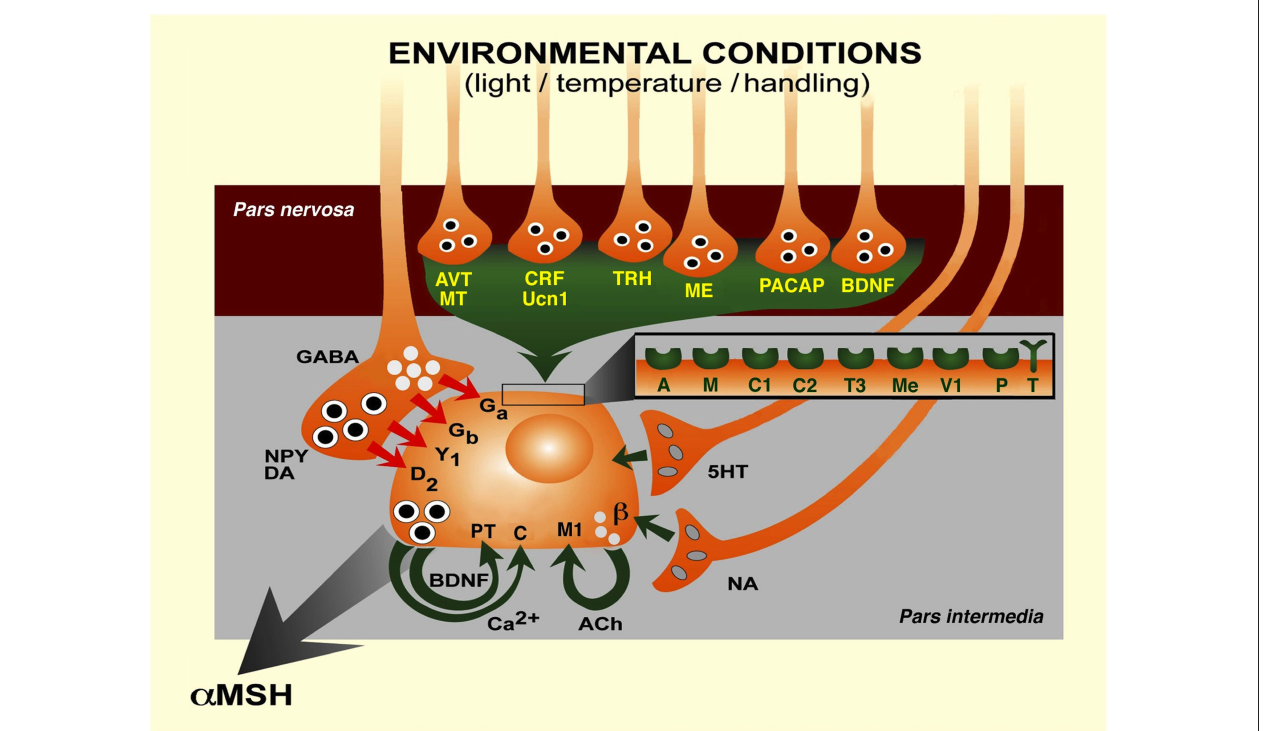
calcium ion; CRF, corticotropin-releasing factor; D , dopamine D receptor; DA, 2 2 dopamine; G , GABA receptor; G , GABA receptor; GABA, γ -aminobutyric acid; a A b B M, mesotocin receptor; M1, muscarinic M1 receptor; ME, metenkephalin; Me, metenkephalin receptor; MT, mesotocin; NA, noradrenalin; NPY, neuropeptide Y; P, P75 NTR receptor; PACAP, pituitary adenylyl cyclase-activating polypeptide; T, TrkB receptor; T3, thyrotropin-releasing hormone receptor 3; TRH, thyrotropin- releasing hormone; Ucn1, urocortin 1; V1, VPAC1 receptor; Y1, NPY Y receptor. 1 (Modified after Roubos et al.,